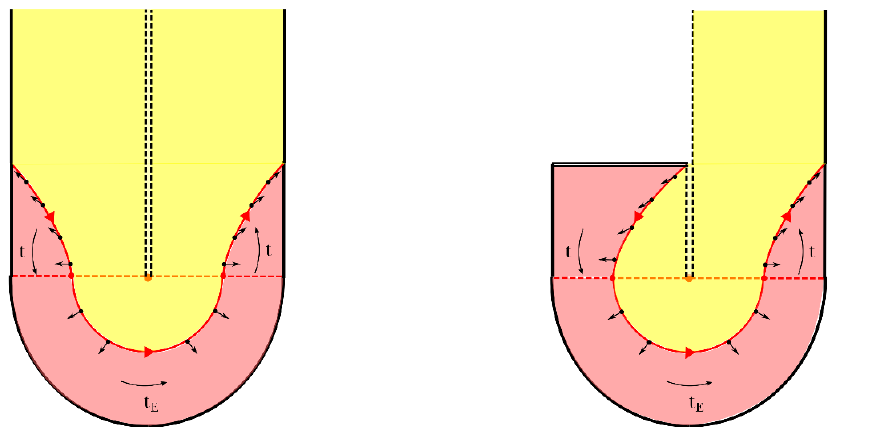
Figure 4 . Schematic diagram of the bubble nucleation when the internal mass is zero. The dashed line refers to r = 0 in AdS. We emphasize that after the nucleation the two resulting AdS spaces disconnect. After the nucleation the shell may collapse or expand due to a small perturbation. Left: the shells in both sides expand. Right: the shell in one side collapses while the other expands. We used again absorptive AdS boundary conditions for